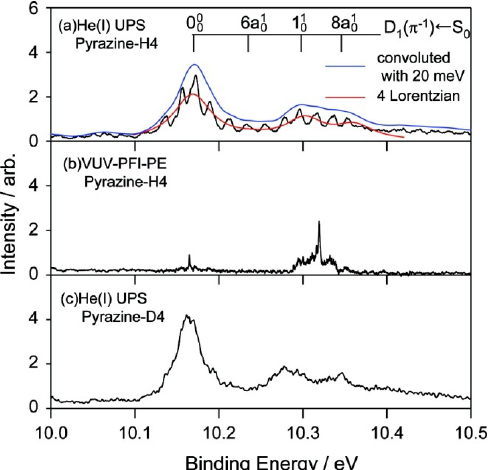
Figure 12. ( a ) Expanded view of the He(I) photoelectron spectrum of jet-cooled pyrazine with vibrational assignments in the D ( π − 1 ) ← S region. Convolution of the observed 1 0 spectrum with a virtual instrumental resolution of 20 meV erases structures due to fine splitting. The envelope of the spectral feature is reproduced using four Lorentzian functions for the bands indicated in the figure; ( b ) VUV-PFI-PE spectrum of pyrazine in the D ( π − 1 ) ← S region; ( c ) He(I) photoelectron spectrum of fully deuterated pyrazine in a 1 0 supersonic jet. Reproduced with permission from Ref. [64], copyright (2008) by American Chemical Society.